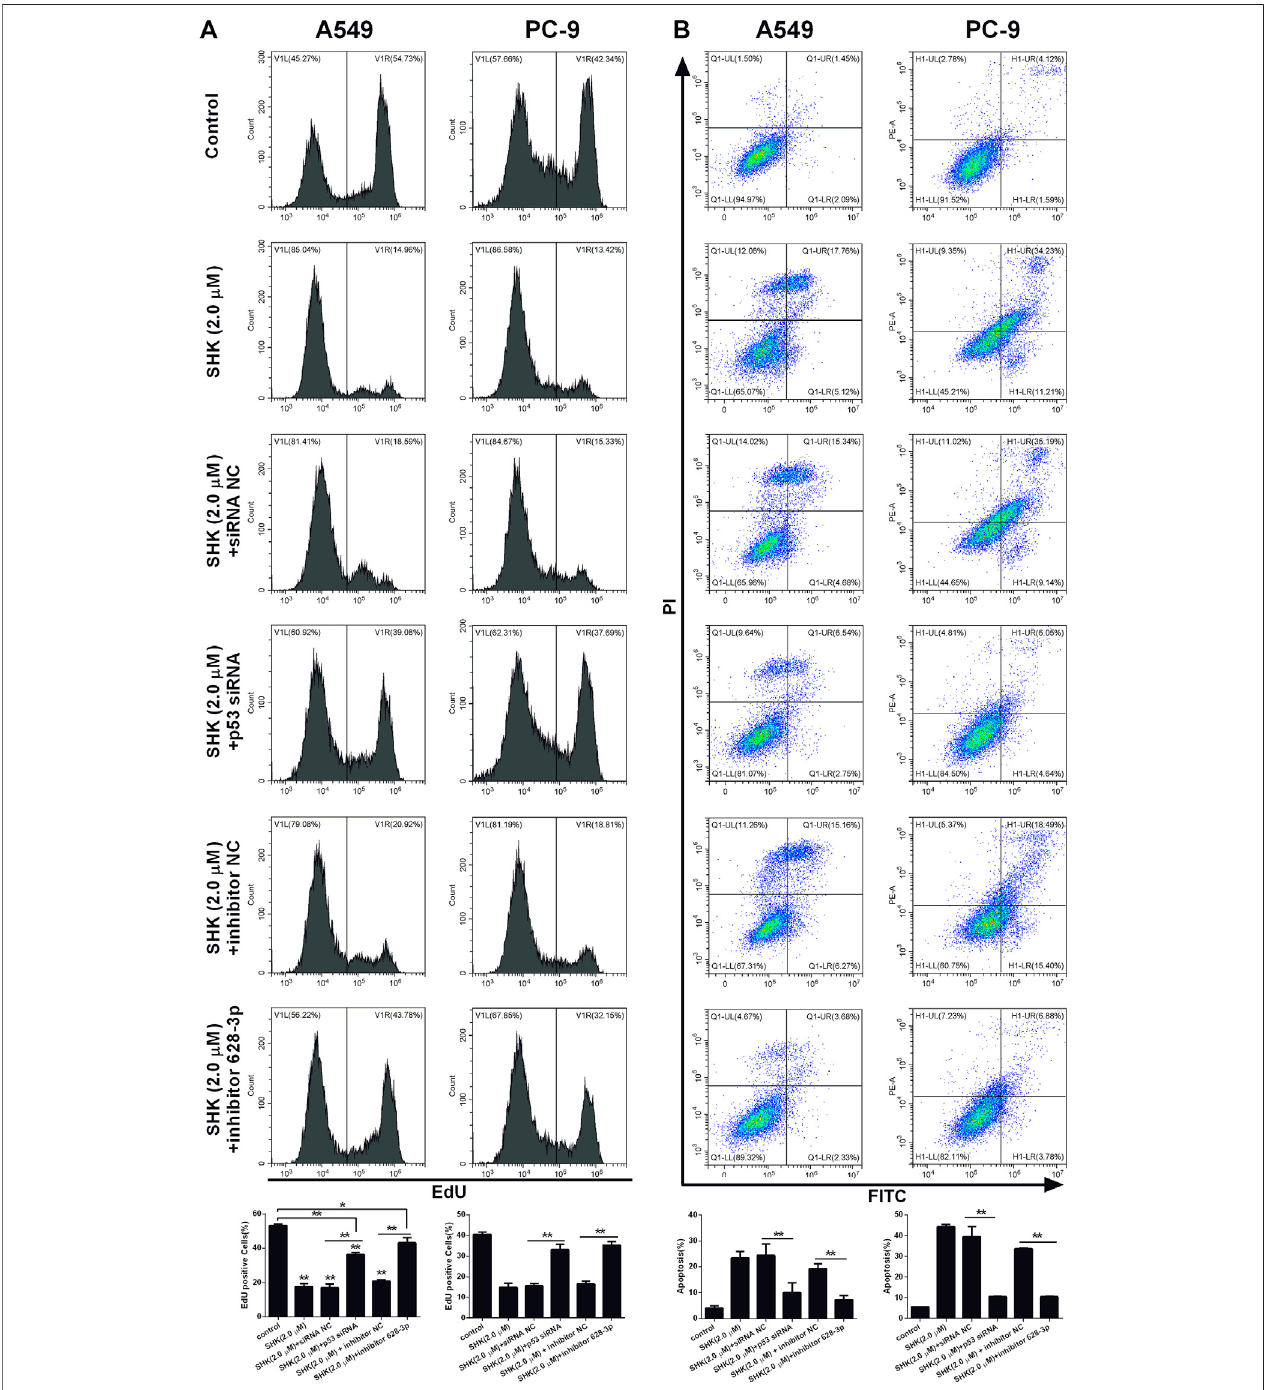
FIGURE 7 | SHK inhibits the growth and induces apoptosis of A549 and PC-9 cells through the p53/miR-628-3p pathway. A549 and PC-9 cells were pretreated with p53 siRNA or inhibitor 628-3p and then cotreated with 2.0 μ M of SHK for 24 h; cells were stained with (A) EdU or (B) annexin V – fl uorescein isothiocyanate/ propidium iodide and analyzed by fl ow cytometry. siRNA NC and inhibitor NC were performed as negative control, respectively. All measurements were carried out in triplicates, and data are given as mean ± SD ( n (cid:2) 3). * p ≤ 0.05, ** p ≤ 0.01.